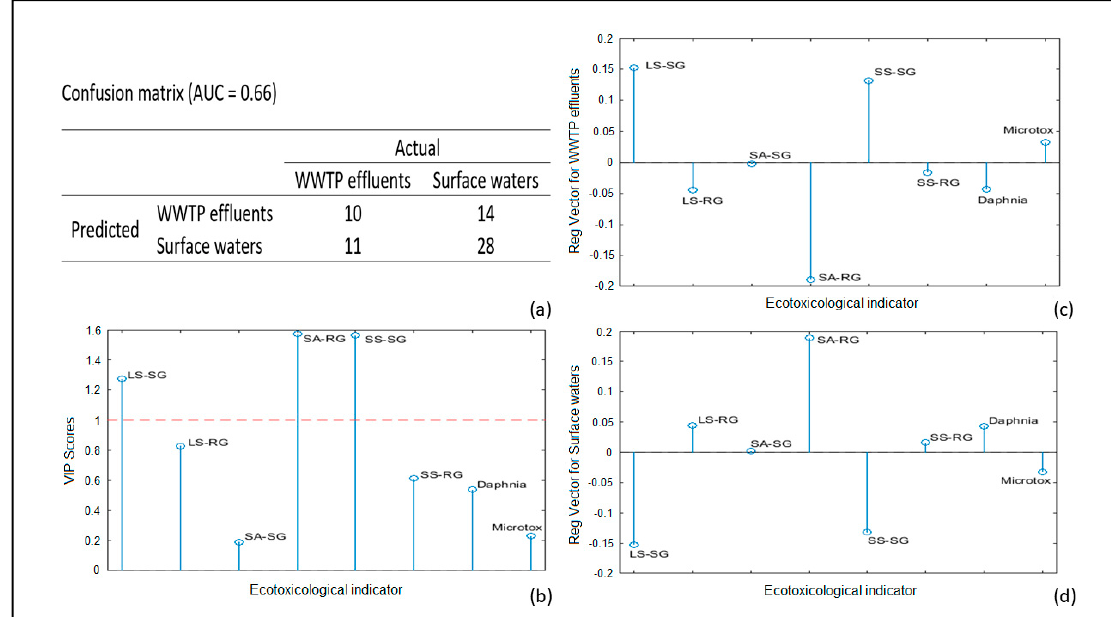
Figure 4. The PLS-DA model results for WWTP effluents and surface waters based on ecotoxicological indicators: ( a ) Confusion matrix; ( b ) VIP scores; ( c ) Regression vector for WWTP effluents; ( d ) Regression vector for surface waters.